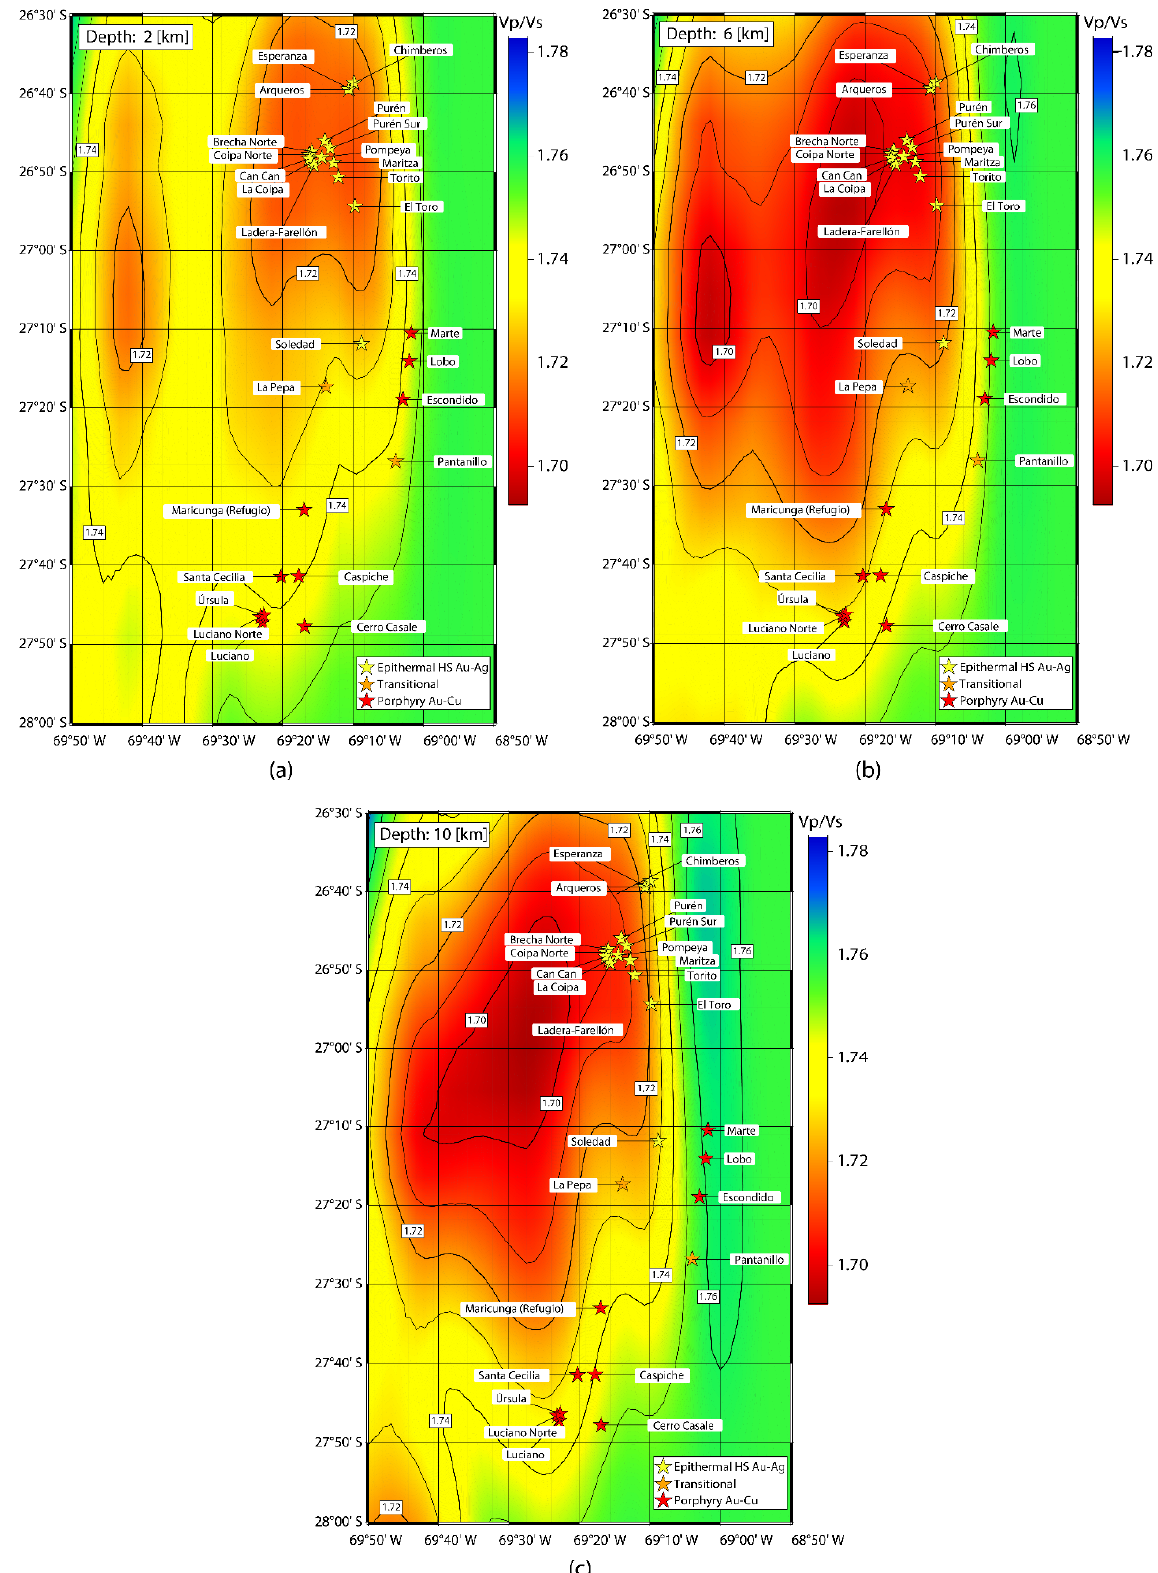
Figure 3. Slices through the Vp/Vs model (with contour intervals of 0.01), where ( a ) represents 2 km, ( b ) 6 km, and ( c ) 10 km depth. Yellow, orange, and red stars represent epithermal high-sulphidation Au-Ag, transitional, and porphyry Au deposits, respectively.